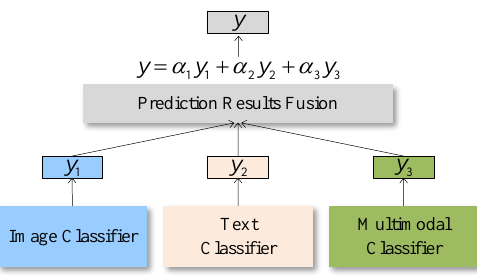
Figure 8. The late fusion of prediction results.